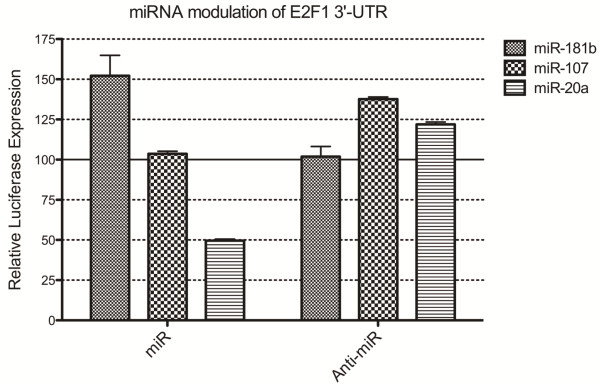
miRNA-mediated regulation of E2F1 3′-UTR reporter gene expression. The sensitivity of the E2F1 3′-UTR to intracellular 181b, miR-107, and miR-20a levels was determined by luciferase reporter gene expression in the presence of either synthetic miRNA or corresponding anti-miR inhibitor. In each case the response was normalised against the respective miRNA and anti-miR control oligos. This data was obtained from n=4 experiments, each performed in triplicate.